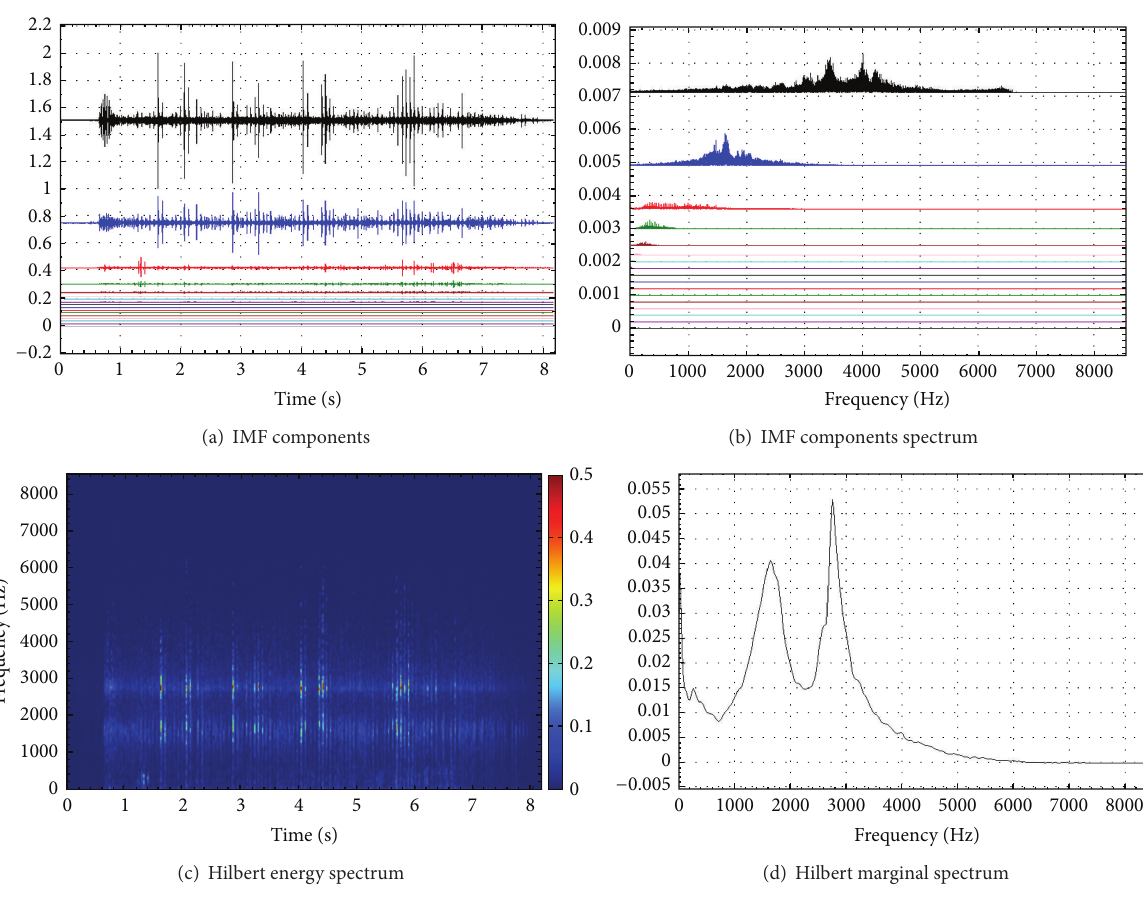
Figure 38: HHT analysis results of working condition